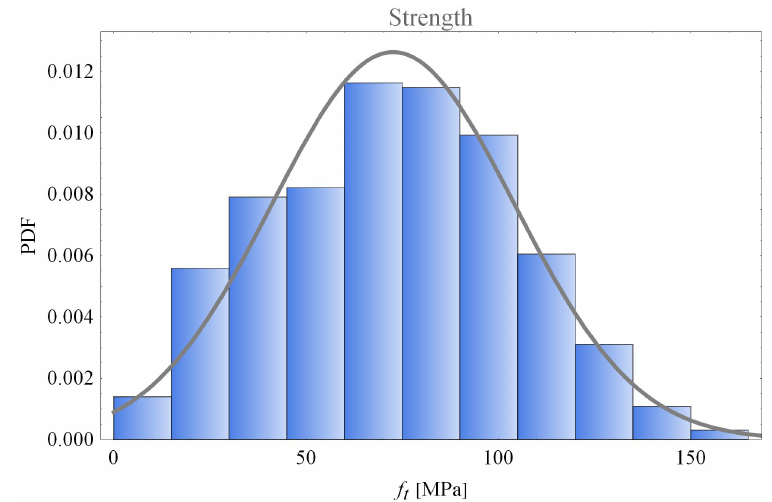
Figure 14. Tension strength adjusted to 150 mm width ( n = 428) with normal PDF.